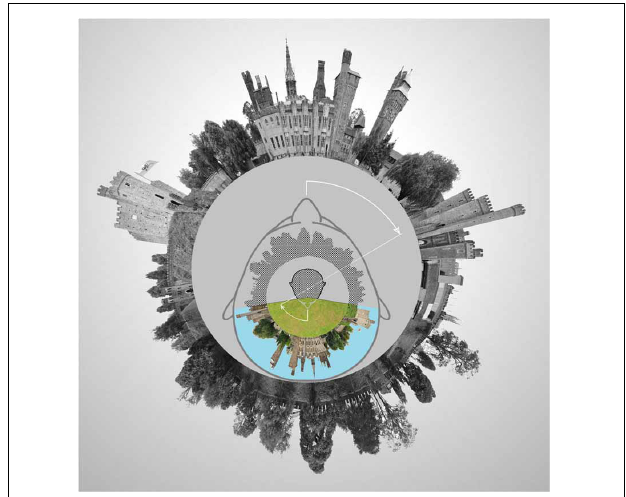
FIGURE 1 | Polar panorama of Cardiff Castle surrounding an observer head, to illustrate the use of an egocentric neural representation of ambient space in the control of rotational displacements of eyes and head during orienting movements. Only a head movement is depicted. For inclusion of eye movements in such a scheme, see Land (2012). The physical universe is rendered in gray scale, while the contents of the neural reality model (shown filling the physical head only to gain image resolution) are rendered in color and raster. Colored sector: The visible portion of the surroundings representated in the neural reality model, anchored to the perceptual egocenter inside the reality model’s head representation (rastered, because not within the field of view). Rastered sector: The remaining multimodal space representation of the neural reality model, tacitly present for vision in the form of sectors of ambient space that may be brought within the field of view by gaze displacements. In such a scheme perceived angular distance to a potential orienting target matches the required rotational displacement of the physical eyes and head (gaze), symbolically indicated by the line joining the two angular displacements. The execution of such a movement is experienced as a movement of one’s (i.e., neural model) head only , while one’s (i.e., neural model) surroundings remain stationary , though the physical surroundings undergo wholesale displacement relative to the sensory receptors fixed to the moving physical eyes and head in the course of that movement. The tacit representation of the surroundings (rastered) accordingly must undergo a corresponding compensatory displacement in the neural reality model, leaving the rastered sector “locked,” as it were, to the physical surroundings despite head movements, presumably in dependence on oculomotor efference copy and vesitibular head movement signals (see further, Land, 2012). The content of the colored sector, of course, is always what is before the eyes. For gaze movements from one primary position to another that content always occupies the same fixed sector of the reality model (i.e., without requiring translatory movement), given surround compensatory movement plus saccadic suppression. In the proposed dorsal pulvinar implementation of such a reality model, the compensatory surround movement can draw on afference from both colliculus and posterior parietal cortex, the latter in receipt of disynaptic hippocampal, cerebellar and collicular (Clower et al., 2001), as well as vestibular (Andersen, 1997), information. The Cardiff Castle panorama photo is from Gregg M. Erickson under a Creative Commons Attribution 3.0 Unported license, modified in polar coordinates by Nevit Dilmen under the same license, further modified for inclusion in this figure by Bjorn Merker and released under the same